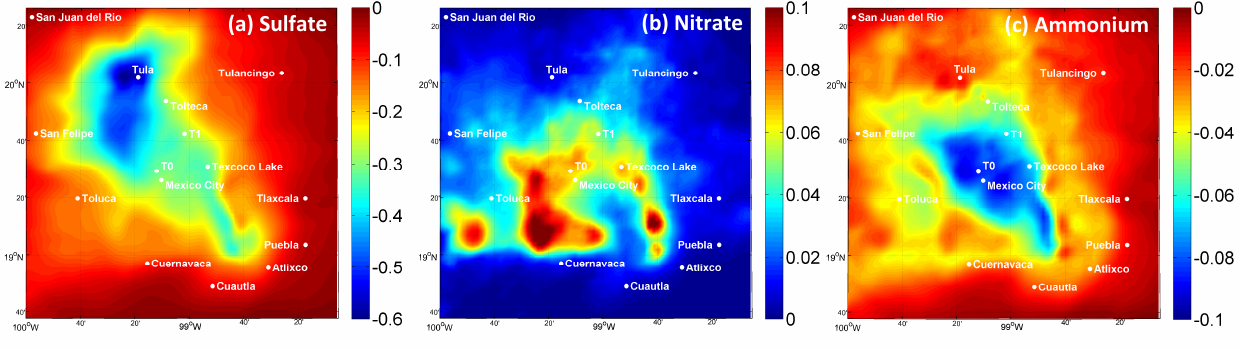
Figure 11: Predicted change (µg m -3 ) in ground-level concentrations of PM 1 (a) sulfate, (b) nitrate, and (c) ammonium after a 50% reduction of SO 2 emissions. A negative change corresponds to a decrease.